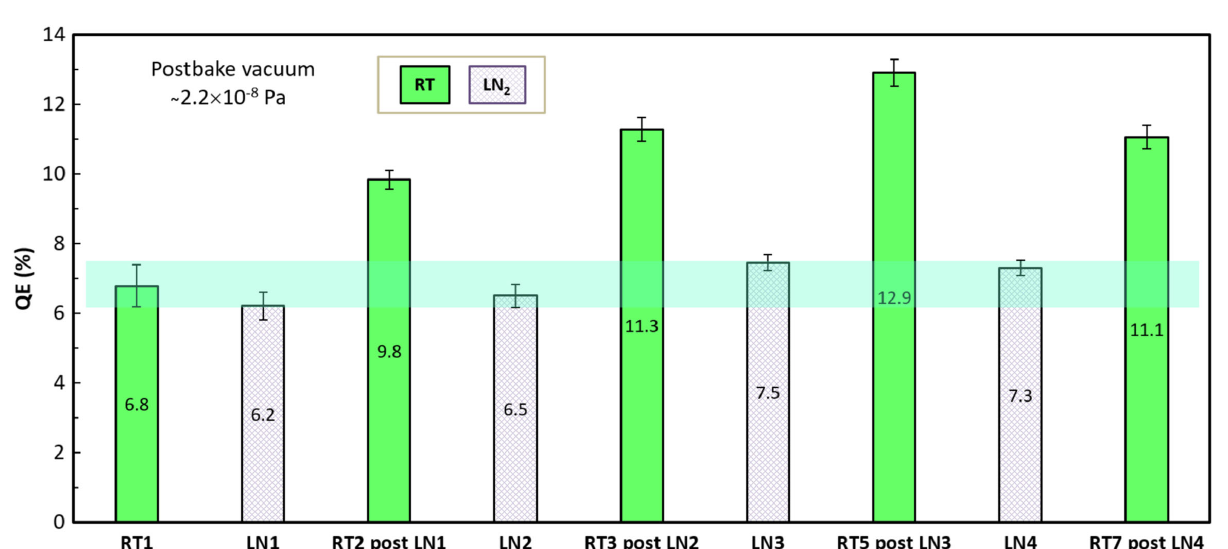
FIG. 2. Photocathode QE at 532 nm following successive iterations of sample cooling and heating inside the baked vacuum chamber. Photocathode QE at 77 K was consistently ∼ 6 % to 7%, and when the sample was returned to room temperature, photocathode QE actually increased from ∼ 7 % to